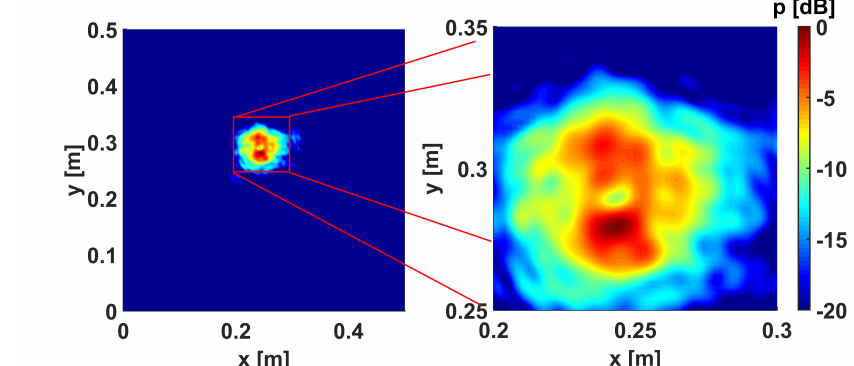
Figure 11. Amplitude at the top of the wooden particleboard with a ø4 mm piece of paper. Evaluated with the spec-radiation method for the frequency 50 kHz, with d x = d y = 2 mm and a grid of the size 256 × 256